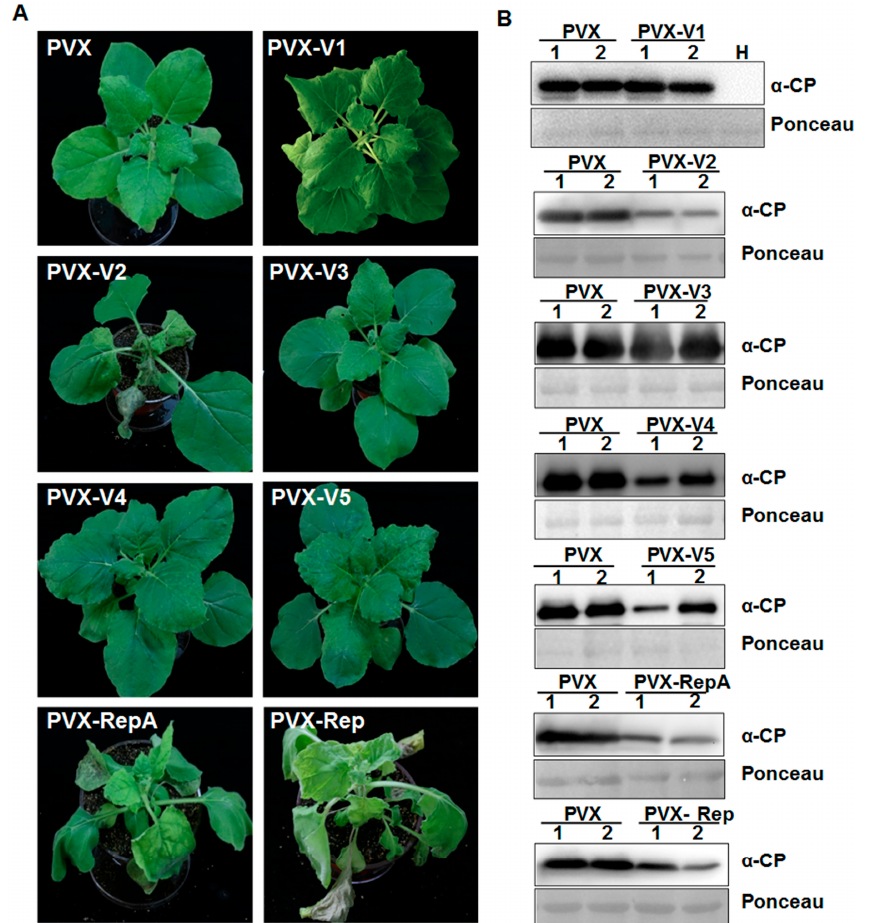
Figure 2. Effects of MMDaV-encoded proteins on potato virus X (PVX) pathogenicity. ( A ) Symptoms of Nicotiana benthamiana plants inoculated with Agrobacterium cells harboring PVX alone, or recombinant PVX vector expressing individual ORFs of MMDaV. Photographs were taken at 10 days post infiltration (dpi). Experiments were repeated three times, and at least four to six plants were used for each inoculation. ( B ) Western blot analysis of PVX accumulation in inoculated N. benthamiana plants at 7 to 10 dpi using a monoclonal antibody against PVX CP. Total proteins were extracted from upper non-inoculated leaves as indicated in ( A ). Two independent plants were used to extract total proteins. H represents total soluble proteins extracted from the healthy N. benthamiana plant, which was used to detect the specificity of the PVX antibody. Ponceau staining of the large subunit of Rubisco served as loading